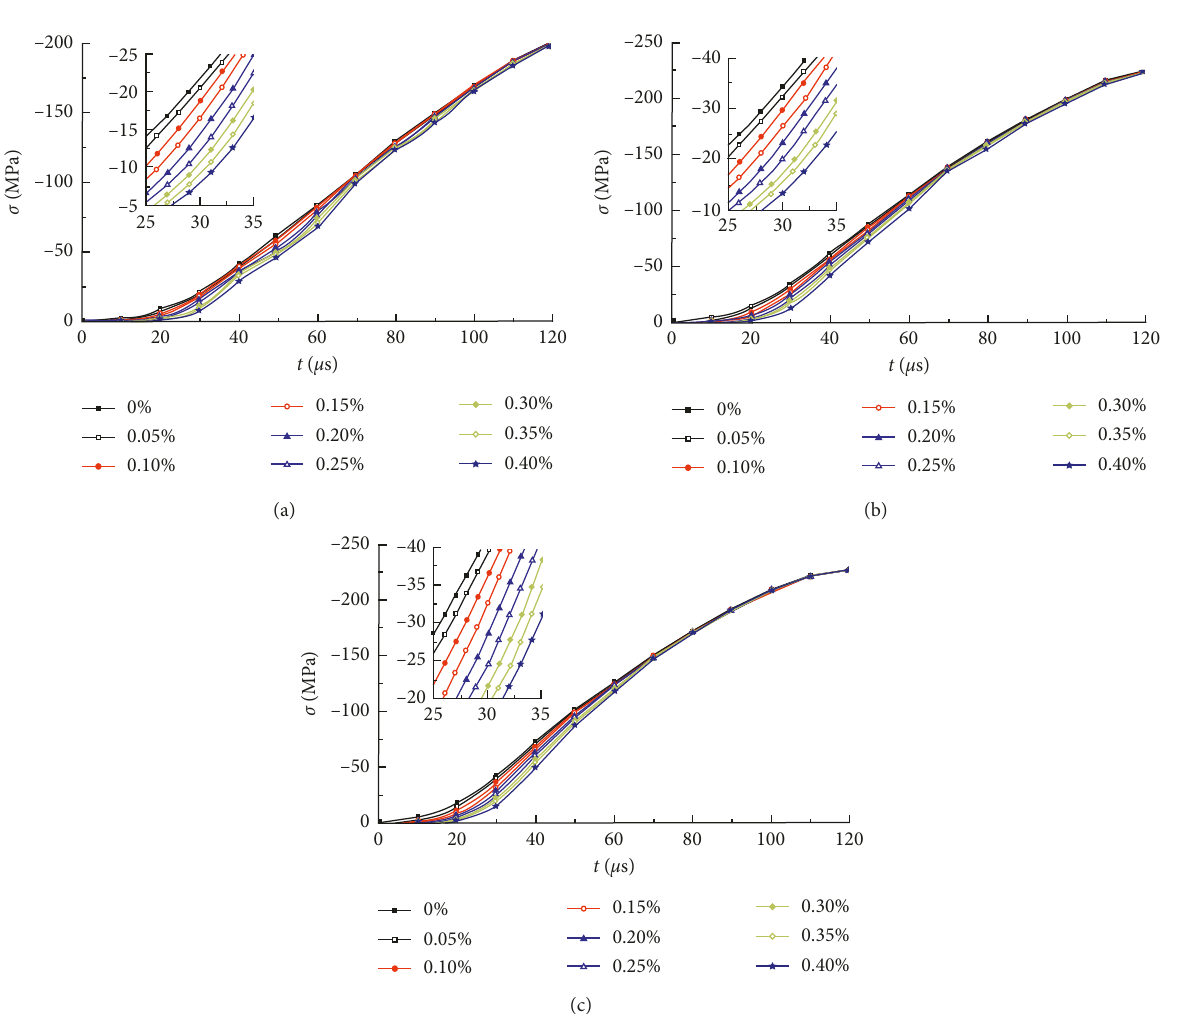
14 GPa, (b) E 28GPa, and (c) E (cid:30) (cid:30) (cid:30)